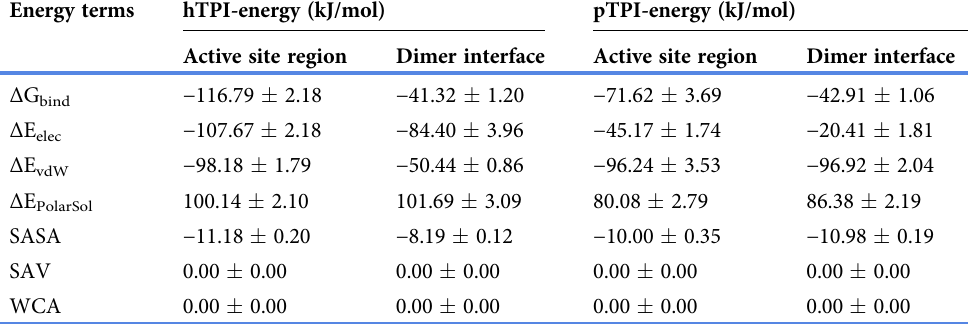
Table 2 MM – PBSA score for the four complexes formed between SulfaE and